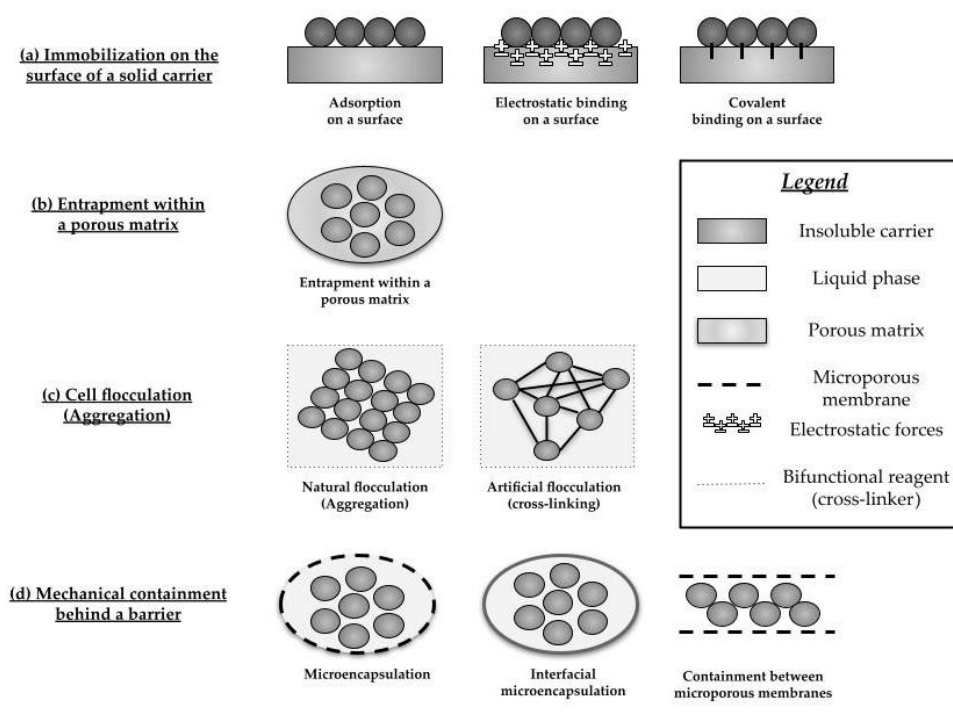
Figure 2. Basic methods of enzymes/cells immobilization. Table 3. Comparison of immobilization methods.